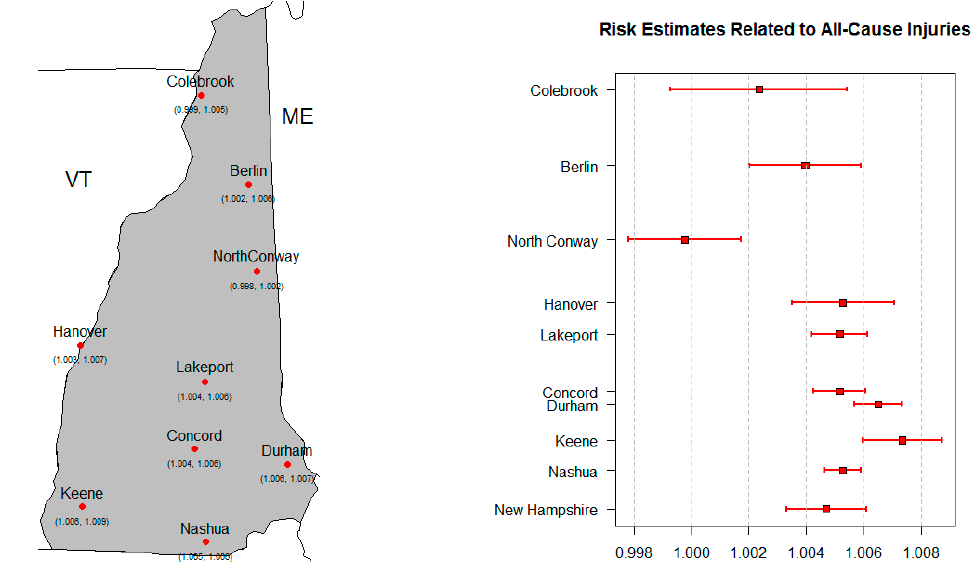
Figure 2. Risk estimates for all-cause injury-related hospital visits associated with a 1°C increase in temperature, reported with a 95% CI.